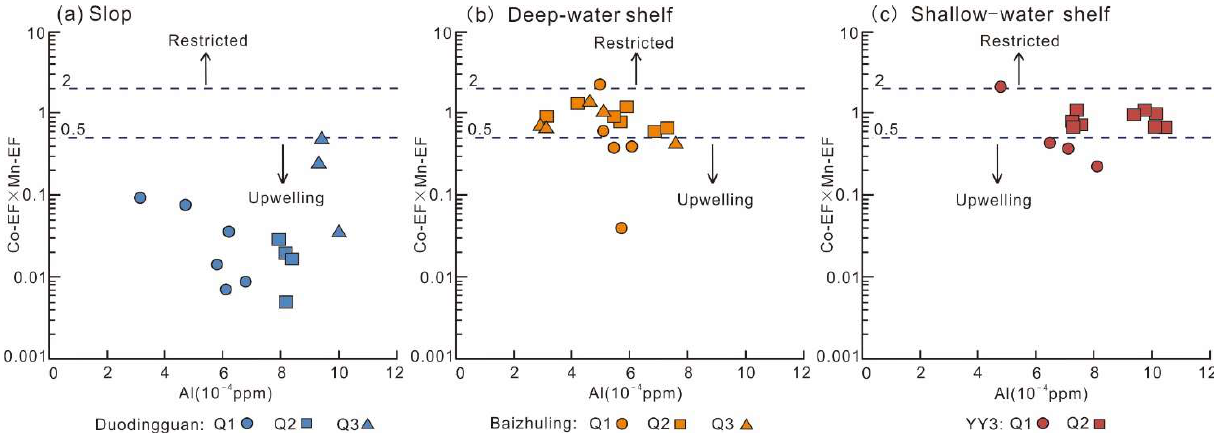
Figure 6. The relationship between Co−EF×Mn−EF and Al in the different zones of the Qiongzhusi Formation in the study area [38]). Co−EF and Mn−EF are the enrichment coefficients of Co and Mn, respectively, which were calculated using Equation (1).